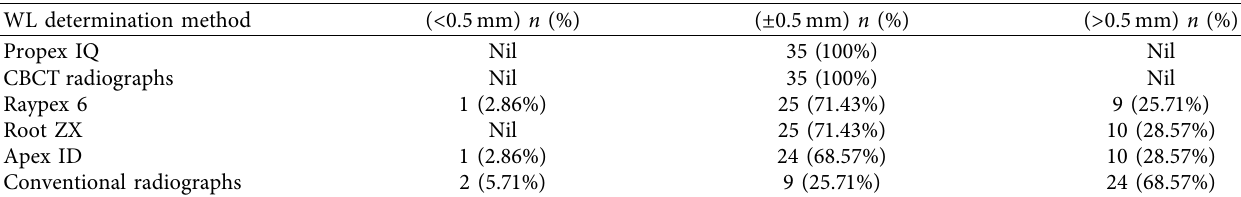
Table 4: Number of teeth ( n ) and frequencies of WL measurements (%) that were less, more, or within 0.5mm from the actual WL. Both groups ( < 0.5 mm and > 0.5mm) were considered to indicate errors in determining the WL of each tooth. WL measurements obtained using CBCT radiographs and Propex IQ showed no errors, whereas the other WL determination methods showed several errors. WL determination